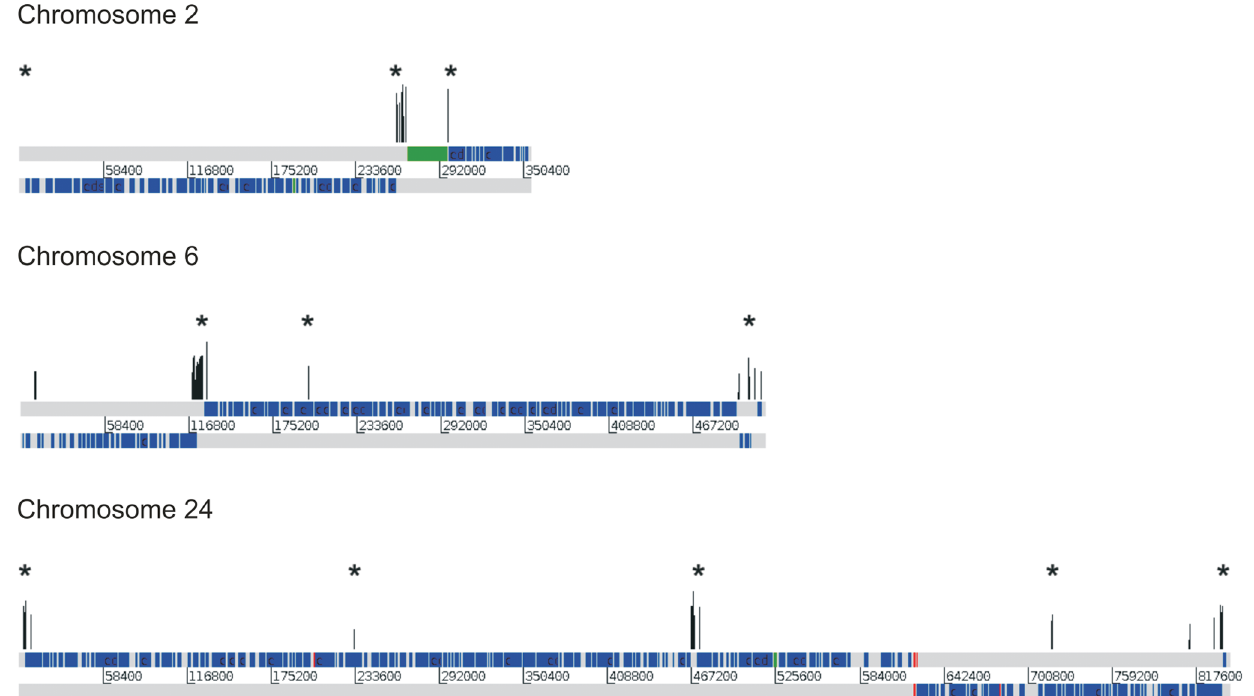
Figure 3. Graphical representation of IC for regions with high RIIC score for three L.major chromosomes. The graphs are the same as figure 1. IC for regions with high RIIC score are represented on top. Asterisks mark sites defined as sites associated with acetylated H3 histone [18].